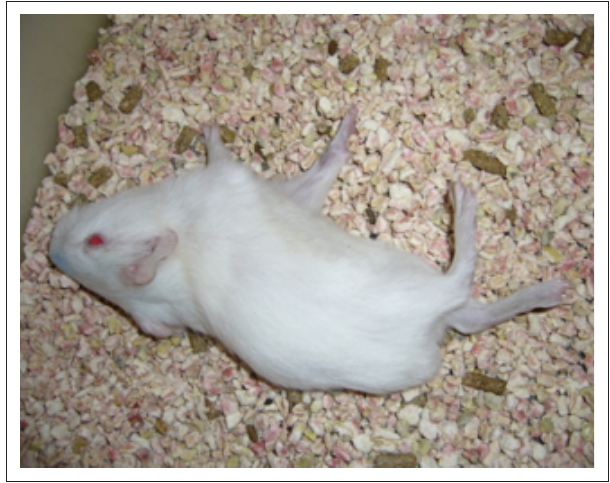
FIGURE 3: Guinea pig (in front) immediately after dosing with diplonine, showing no clinical signs (normal).